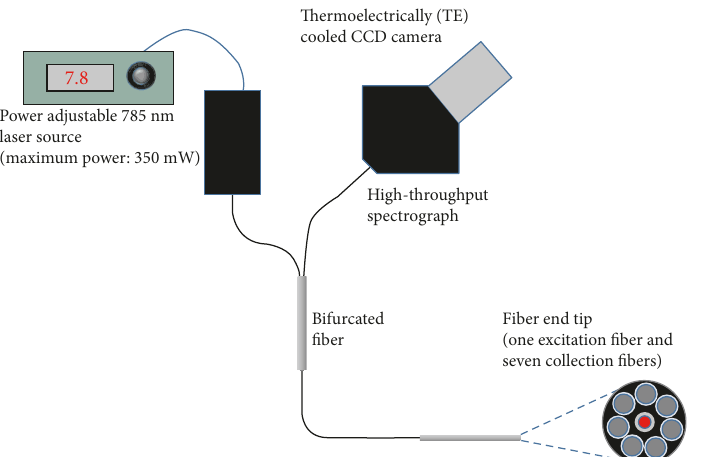
Figure 1: Schematic of the Raman system. One centered excitation fi ber and seven surrounding collection fi bers were con fi gured as a bifurcated fi ber. A power adjustable 785nm laser source (maximum power: 350mW) coupled with the excitation fi ber was used as the excitation source, and a thermoelectrically (TE) cooled CCD camera coupled to a high-throughput spectrograph collects spontaneous Raman signals transmitted through the seven collection fi bers.